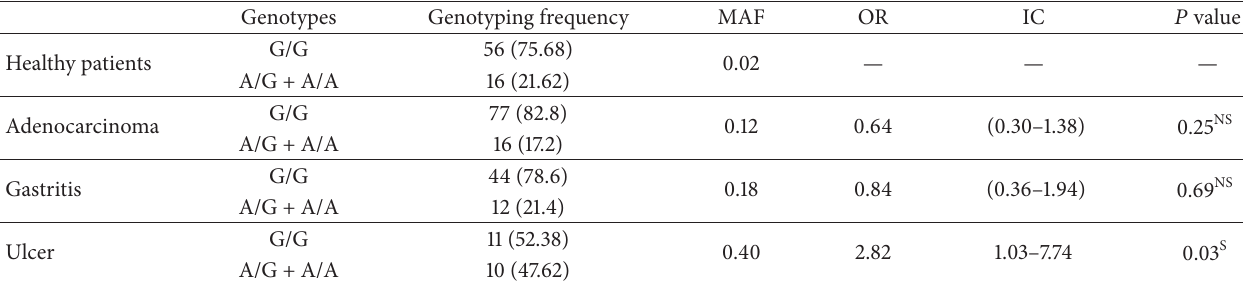
Table 2: Association of a new single-nucleotide polymorphisms TNF- 𝛼 − 193 (G/A) with gastric pathology.